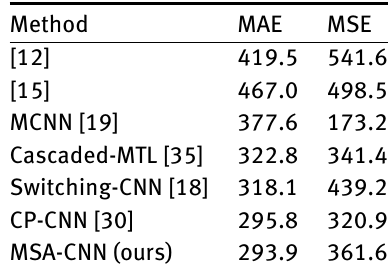
Table 3: Comparisons on UCCF_CC_50 dataset.